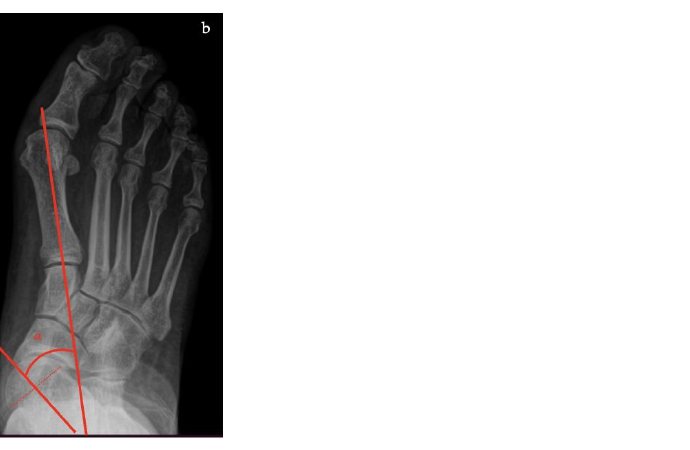
Figure 1. Taler-first metatarsal angle in the anteroposterior view (between the long axis of the talus and the long axis of the first metatarsal). ( a ) Normal foot, 3°; ( b ) pathological flatfoot, 30°.